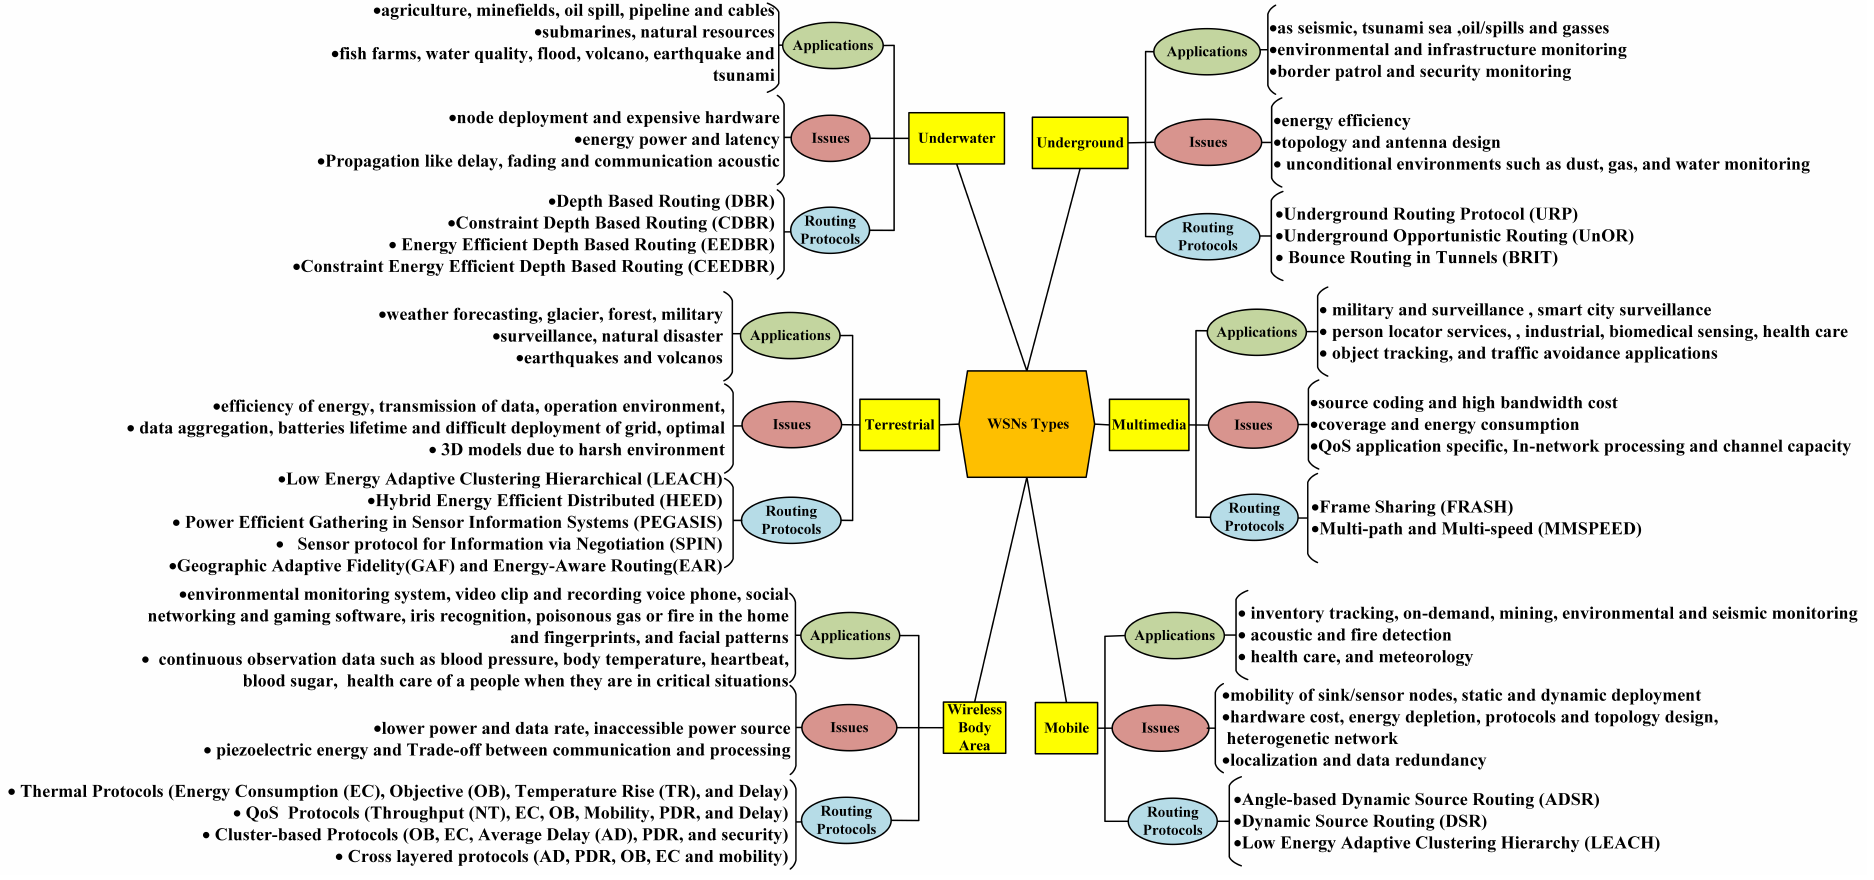
Figure 2. WSNs various types, applications, architectures, data models constraints, and